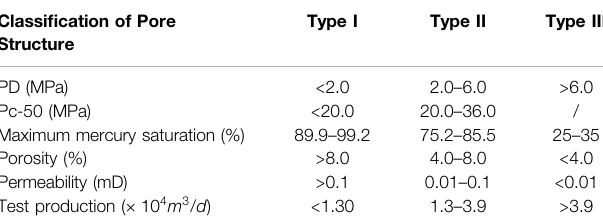
TABLE 3 | Typical mercury injection curves and characteristic parameters of volcano rocks with different pore throat types. Classi fi cation of Pore